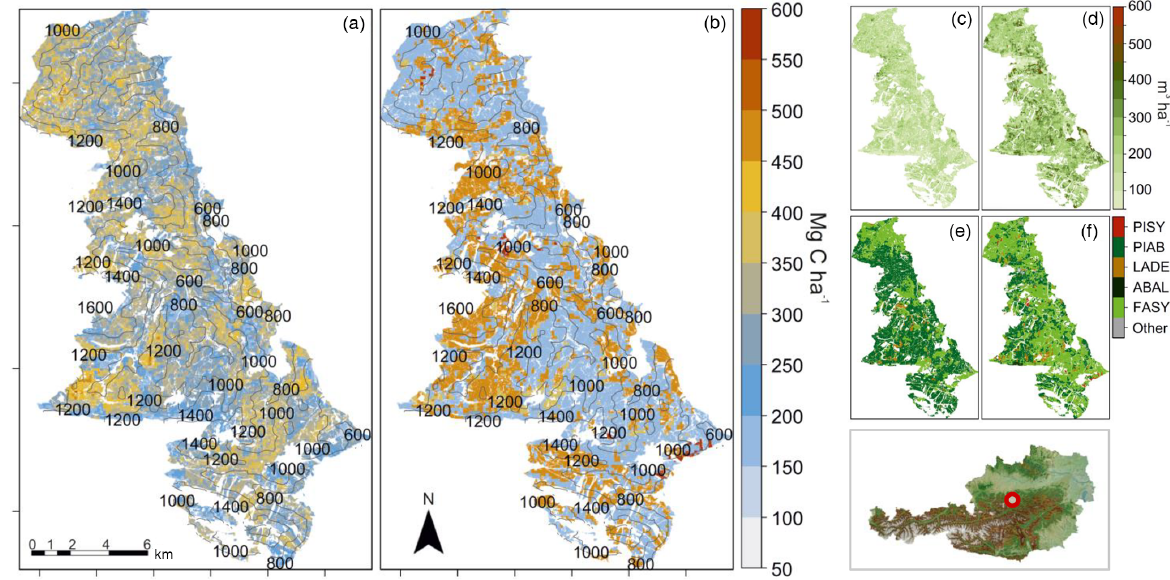
Figure 1. State of forest ecosystem attributes across the study landscape in 1905 and 2013 and the location of the landscape in Austria (lower right panel). Panels (a) and (b) show the distribution of total ecosystem carbon, while panels (c) and (d) present growing stock and panels (e) and (f) indicate the dominant tree species (i.e., the species with the highest growing stock in a 100m pixel) in 1905 and 2013, respectively. PISY = Pinus sylvestris , PIAB = Picea abies , LADE = Larix decidua , ABAL = Abies alba , FASY = Fagus sylvatica . “Other” refers to either other dominant species not individually listed here due to their low abundance or areas where no trees are present. Isolines represent elevational gradients in the landscape (in